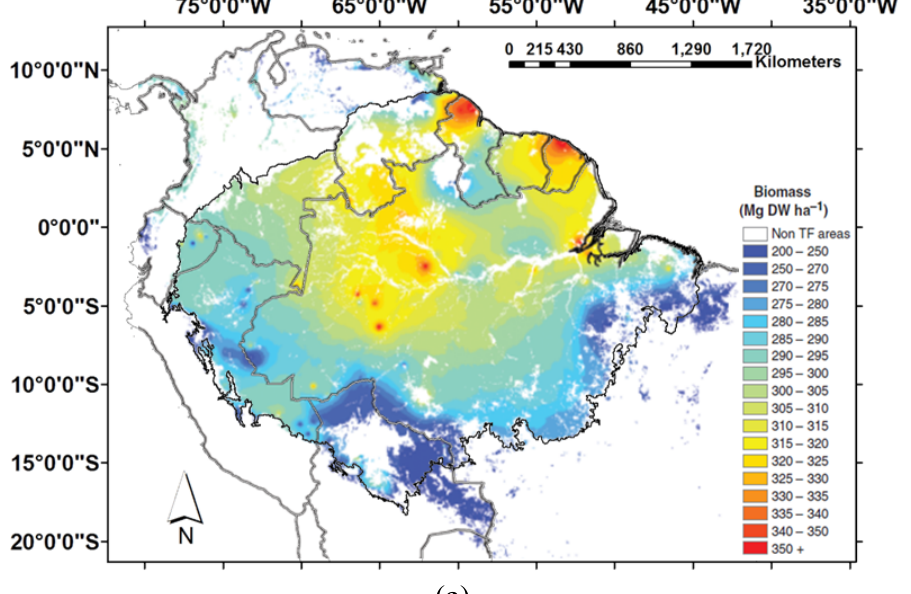
Figure 1. Biomass and canopy height estimates for Amazonia. ( a ) Interpolations of biomass calculated by overlaying basal area estimate with maps of the structure and wood density function (Adapted from [1]); ( b ) 1 km spatial resolution map derived from combined remote sensing and field data through a decision tree method and regression analysis with 11 biomass classes and overall accuracy of 88% (Adapted from [2]); ( c ) 1 km spatial resolution canopy height data from [53], available online: